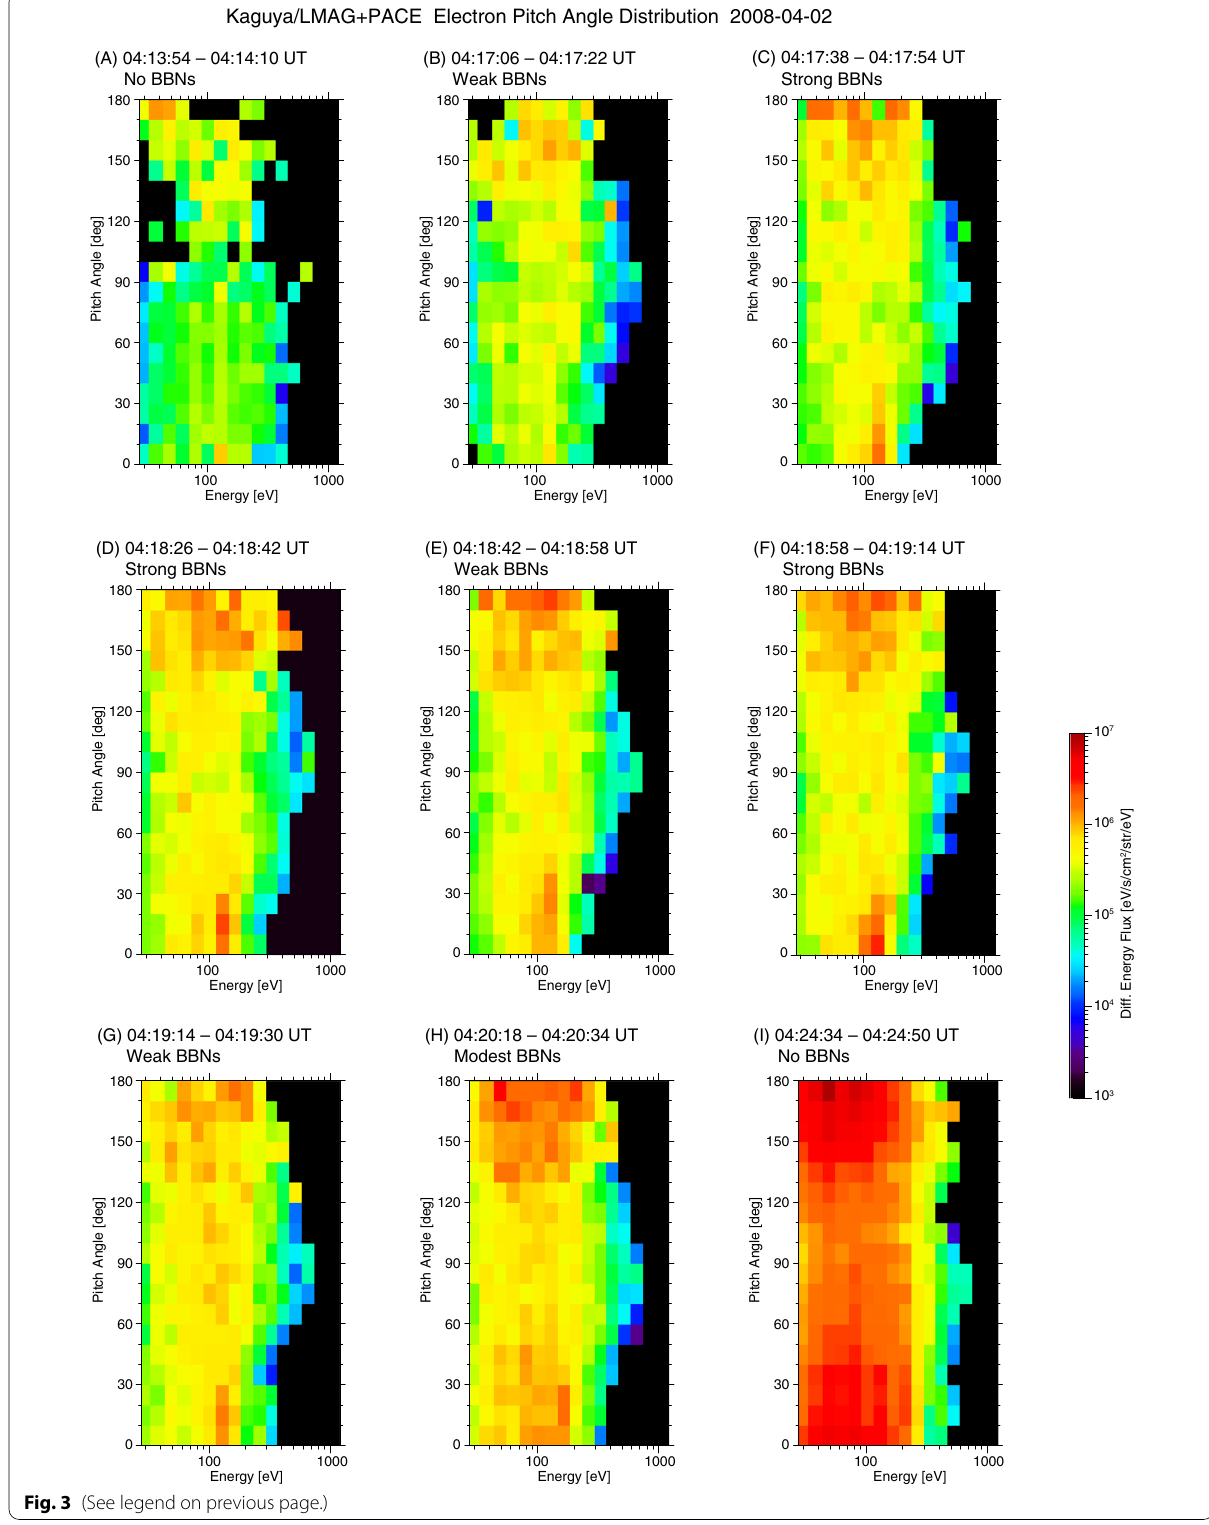
Fig. 3 (See legend on previous